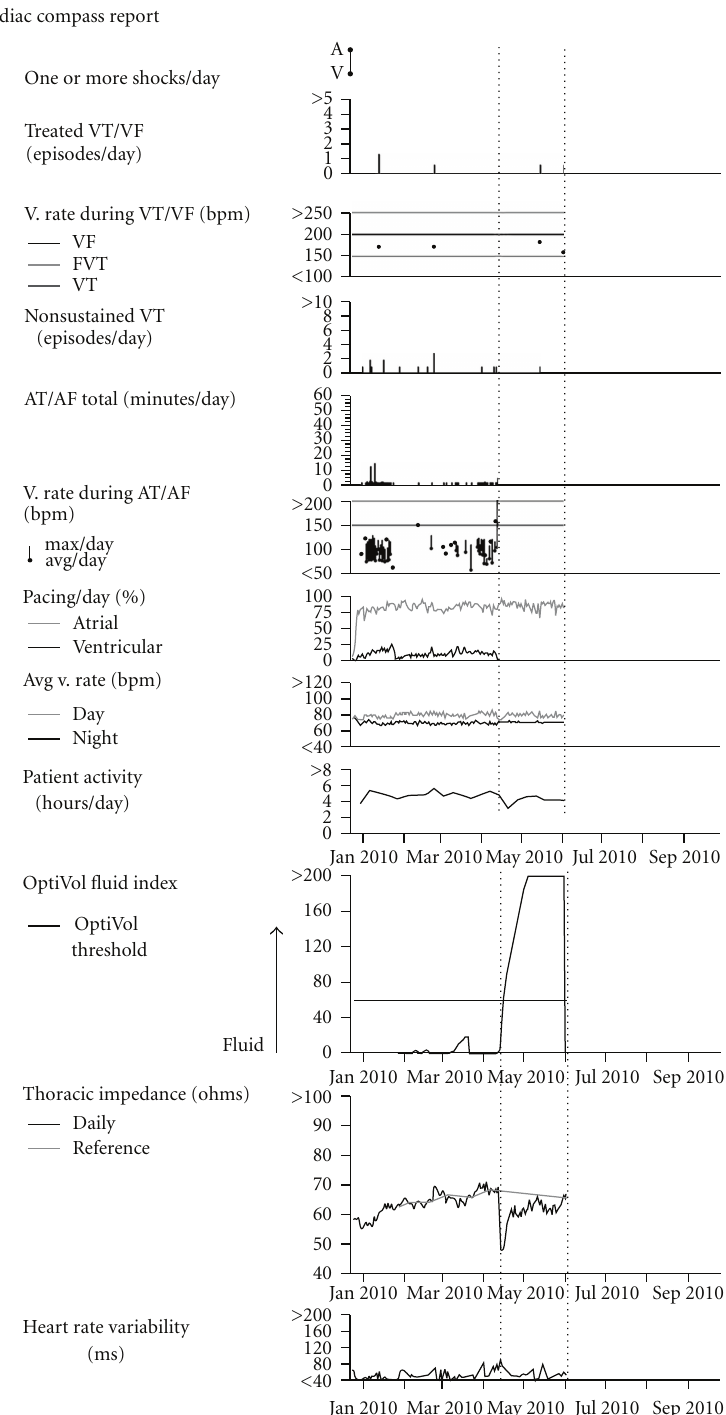
Figure 2: Cardiac Compass report. The Cardiac Compass report displays a number of device diagnostic parameters over a period of weeks to months. This allows trending of data over time, allowing clinicians to monitor the heart failure status of patients. An abnormal reading (such as a fluid index threshold crossing) may reflect a worsening of the patient’s heart failure (HF) status, potentially alerting the physician to a possible HF exacerbation in the near future. The combined use of multiple device parameters may improve the diagnostic sensitivity of early HF